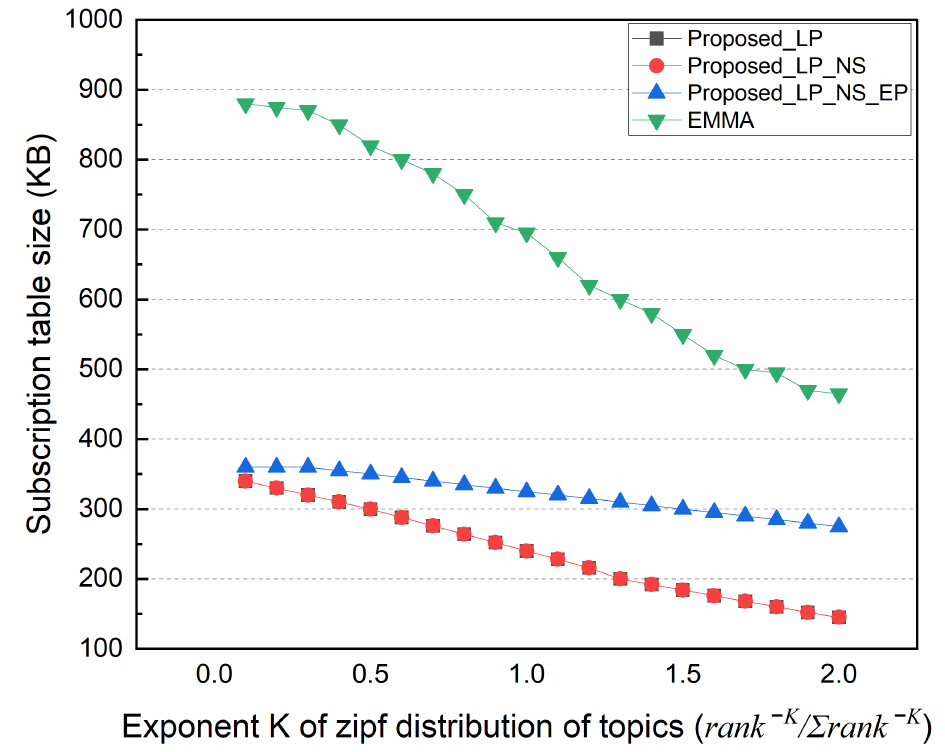
Figure 16. Subscription table size according to popularity concentration of